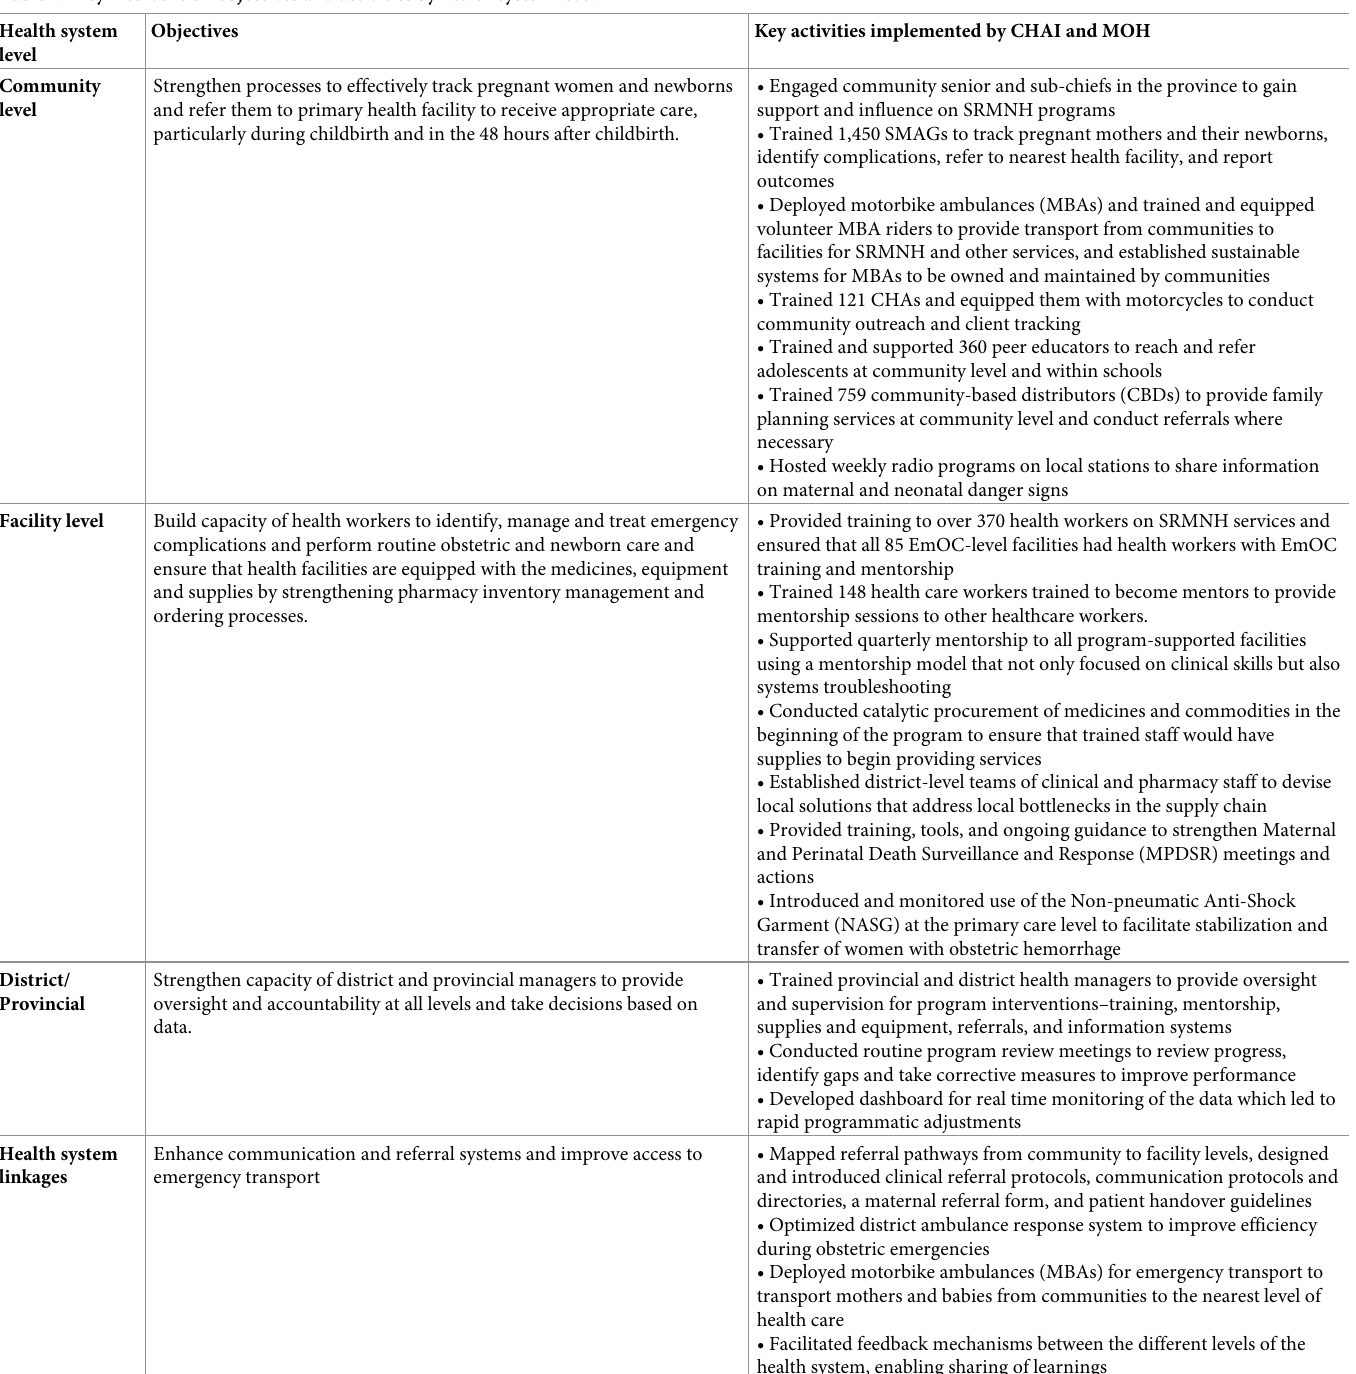
Table 1. Key intervention objectives and activities by health system